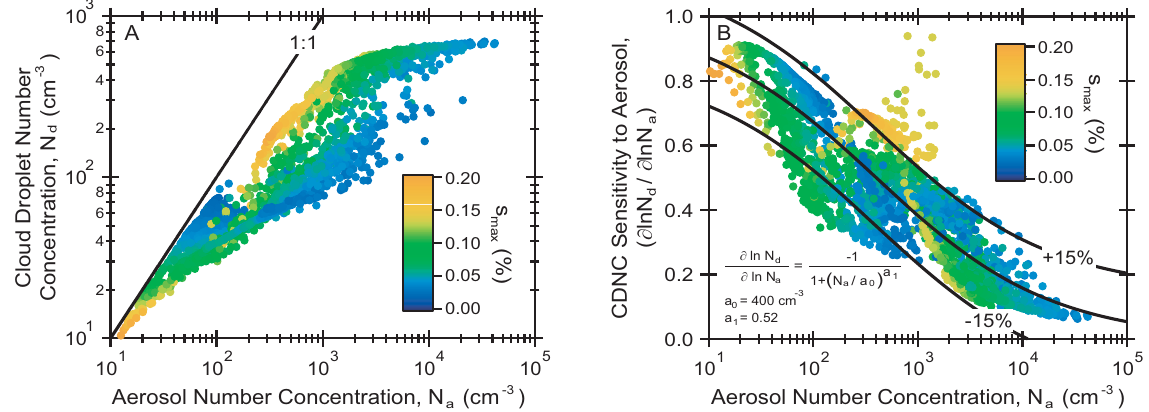
Fig. 2. Simulated N d (left) and sensitivity of N d to N a (right) plotted versus simulated N a for all grid model grid cells. Each point reflects one grid cell of the global annual mean values shown in Fig. 1, and are coloured by the grid-cell s max .